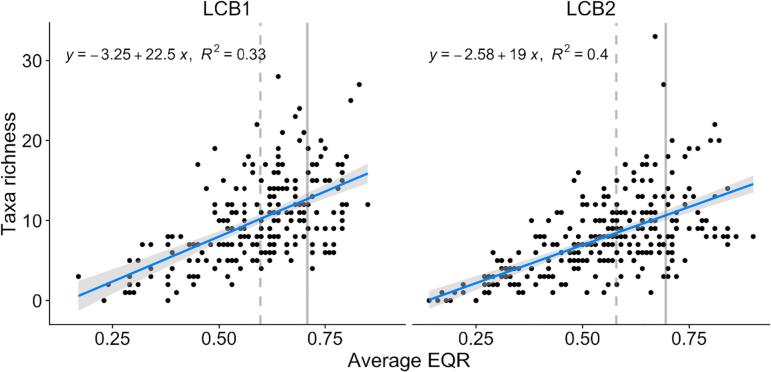
Change of total macrophyte richness along ecological status gradient. Vertical lines represent the boundaries of ‘good’ and ‘moderate’ (dashed) or ‘high’ and ‘good’ (solid) ecological status.